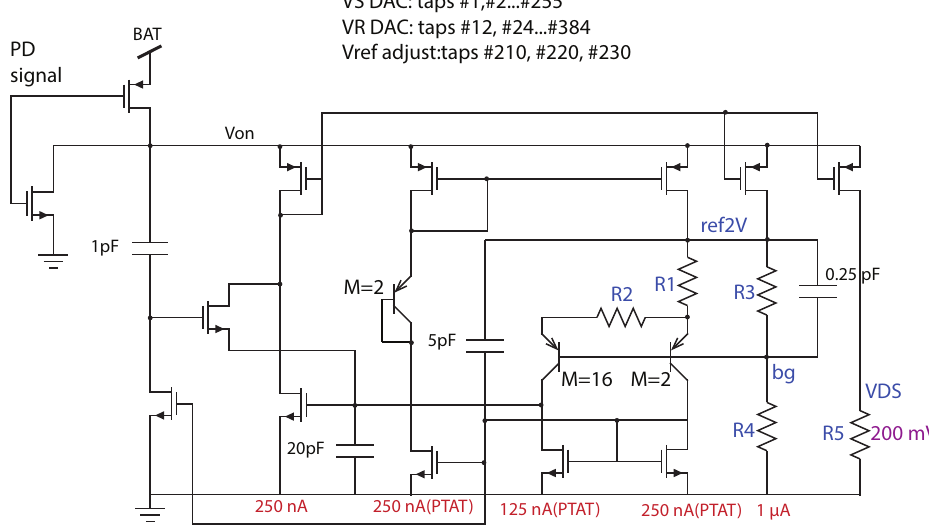
Figure 5. Bandgap voltage reference and resistive